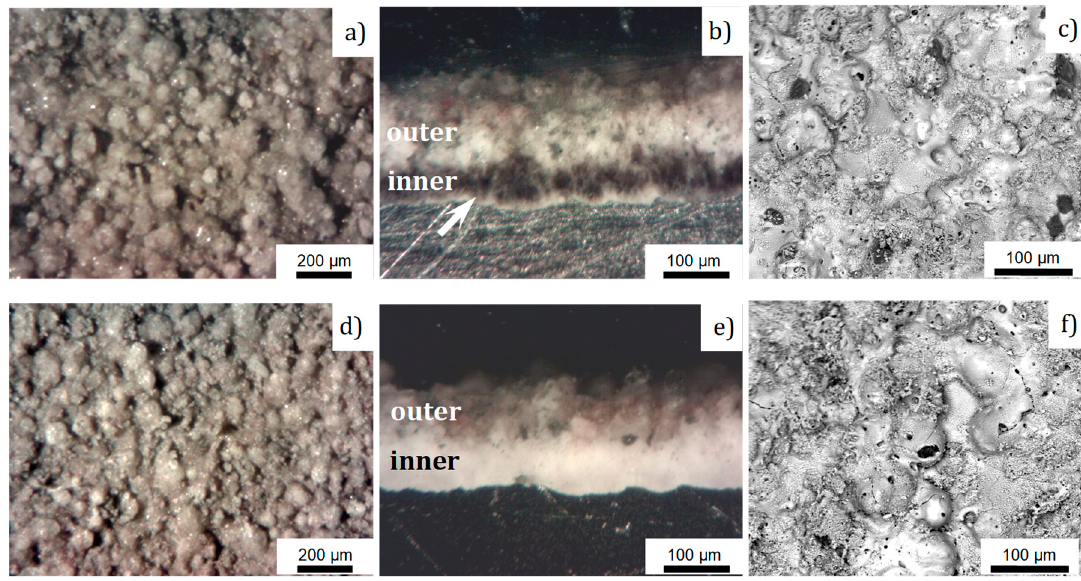
Figure 2. Appearance of the clutch disks with a plasma electrolytic oxidation (PEO) coating including basalt mineral powder.